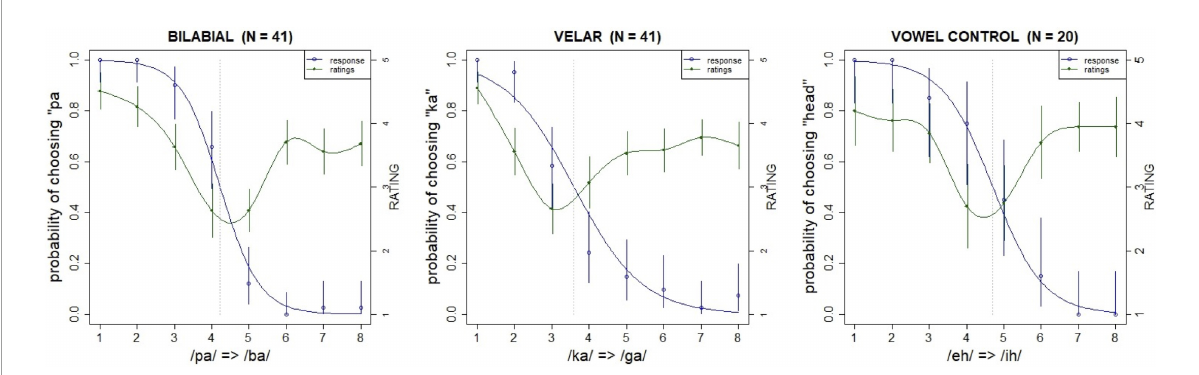
FIGURE1 Viability test results for the continua: left scale (blue line) shows probability of choosing voiceless (“pa” or “ka”) or “head” relative to step (dotted vertical line marks 50% crossover point); right scale (green line) shows Likert scale ratings by step. Error bars show 95% confidence intervals.